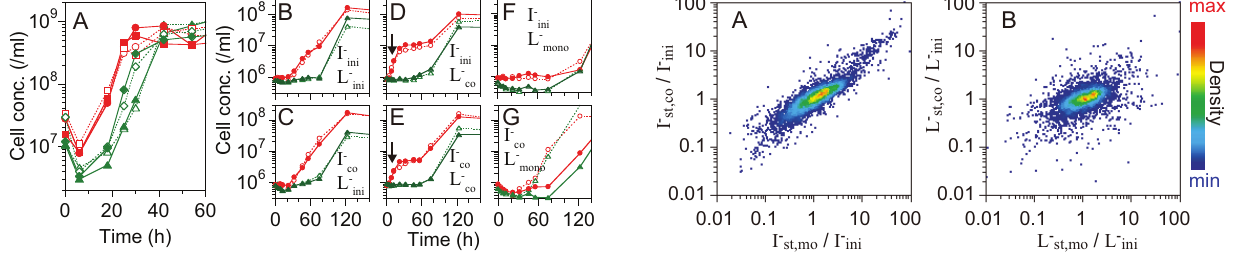
Figure 4. The change in gene expression of cells in coculture compared with cells in monoculture. The ratios of the intensity of expression of each gene at the stationary phase of coculture (subscript ‘‘st,co’’; see text for the details) and monoculture (‘‘st,mo’’), compared with those in their common initial state (‘‘ini’’), were calculated for all 4345 genes and plotted on the vertical and horizontal axes, respectively. The horizontal axis represents the changes from the log phase in the monoculture to the stationary phase in the monoculture, i.e. , only changes in the phase of growth. The vertical axis represents the changes from the log phase in the monoculture to the stationary phase in the coculture, i.e. , sum of the coculture-specific changes and the changes in the phase of growth. The dot densities are shown as a heat map. (A) Changes in gene expression of I – cells. The slope of the linear regression of the log value was 0.67 and the correlation coefficient ( R ) was 0.89. (B) Changes in gene expression of L – cells. The slope of the linear regression of the log value was 0.37 and R was 0.54.